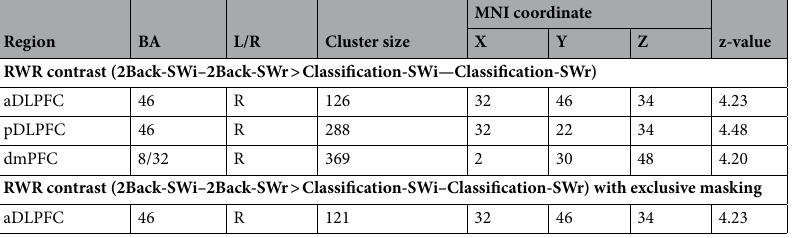
Table 1. Significant areas of retrieval of weak representations (RWR). All z-scores listed above were found at FDR-corrected p < 0.05 with the cluster size defined at a voxel level, uncorrected p < 0.001. BA Brodmann area, L left, R right, a anterior, p posterior, DLPFC dorsolateral prefrontal cortex, dmPFC dorsomedial prefrontal cortex, SWr switch-relevant, SWi switch-irrelevant.